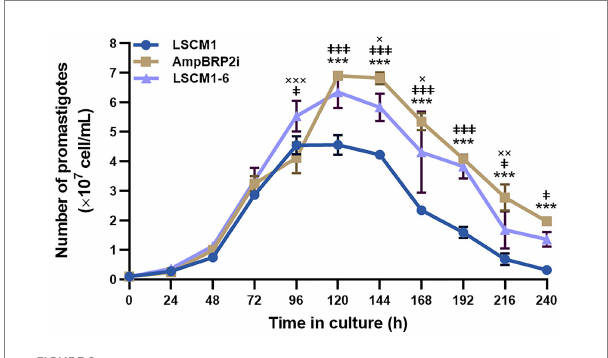
FIGURE 2 Growth curves of the L. martiniquensis LSCM1, AmpBRP2i, and LSCM1-6 promastigotes cultured in the SIM supplemented with 10% (v/v) hiFBS and 25 μ g/ml gentamycin sulfate, pH 6.8 at 26 ° C. All parasites were inoculated at 1×10 6 parasites from stationary growth phase/mL and were counted daily until day 10 (240 h). Statistically significant differences between LSCM1 and AmpBRP2i are indicated as *** = p < 0.001; LSCM1 and LSCM1-6 are indicated as ǂǂǂ = p < 0.001, ǂǂ = p < 0.01, and ǂ = p < 0.05; AmpBPR2i and LSCM1-6 are indicated as ××× = p < 0.001 and ×× = p < 0.01, and × = p < 0.05.